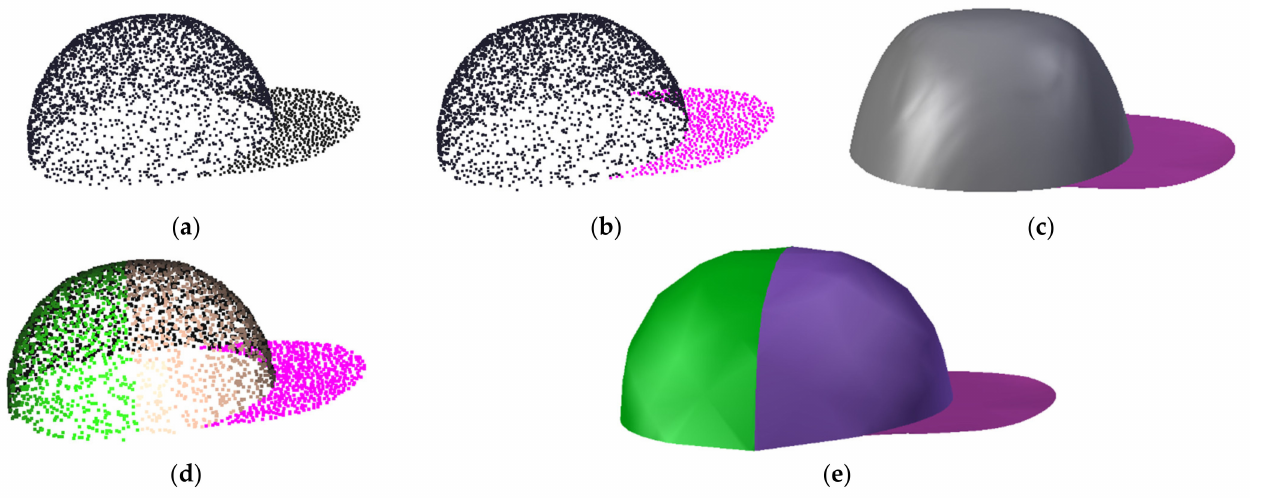
Figure 11. ( a ) The point cloud of a hat; ( b ) segmented 2 subsets; ( c ) reconstructed PDE-based surface using 2 PDE patches defined by the 64-variables PDE model; ( d ) segmented 3 subsets; ( e ) reconstructed PDE-based surface using 3 PDE patches defined by the 64-variable PDE